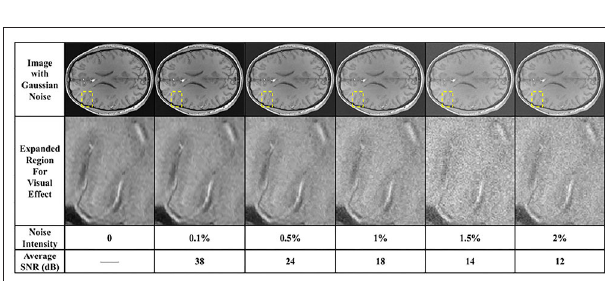
FIGURE 8 | Illustration of a slice with different magnitudes of Gaussian noise. Window level is 240 and window width is 240. The region marked by yellow dash-line rectangle is expanded for better visual effects. Averaged : signal to noise ratioes (SNRs) between images with added noise and the original image were listed in the last